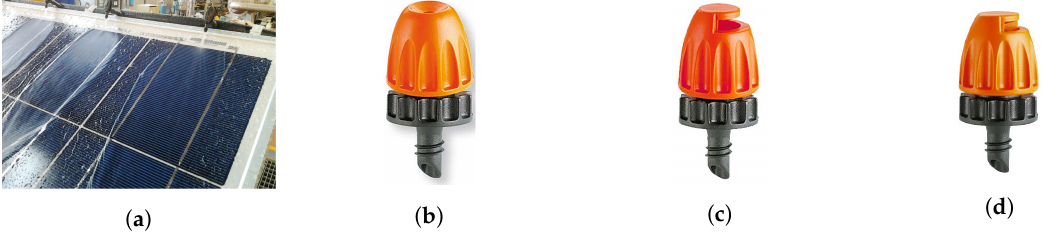
Figure 12. ( a ) Jet sprinkler, ( b ) Nozzle with 360 ◦ of spraying angle, ( c ) Nozzle with 180 ◦ of spraying angle, ( d ) Nozzle with 90 ◦ of spraying angle. By courtesy of [68].